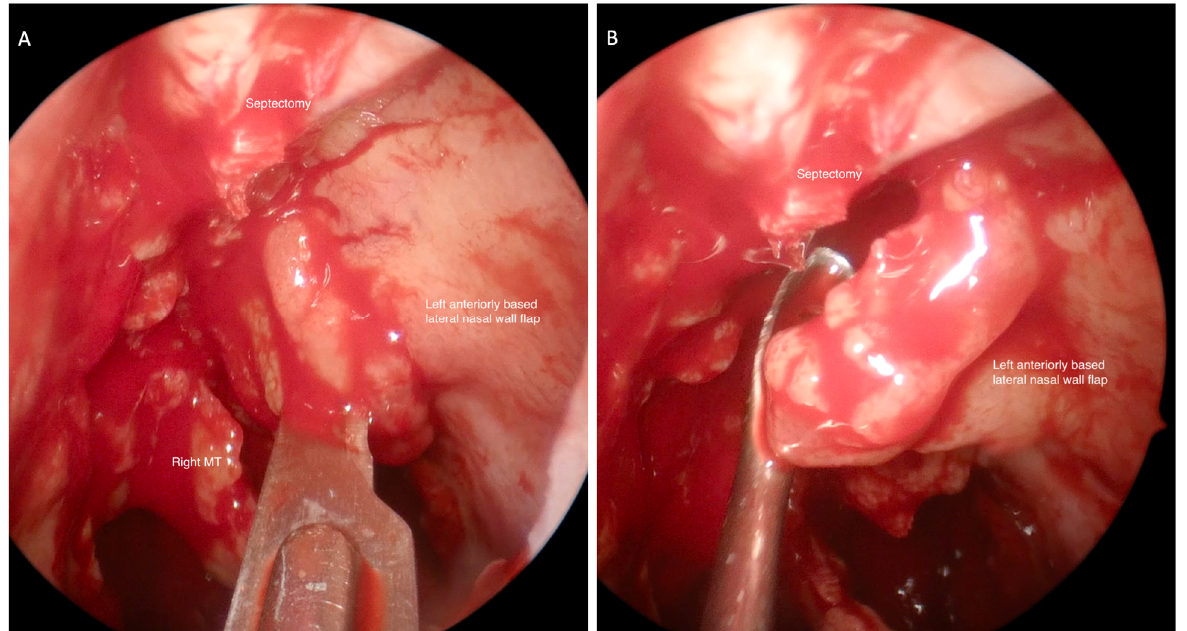
Figure 1. Endoscopic view through right nasal cavity septectomy. ( A ) Raising of a left anteriorly- based lateral nasal wall flap. ( B ) Flap advanced forward and placed into the nasal vestibule to avoid injury during drilling of the frontal sinus ostium. MT—middle turbinate.